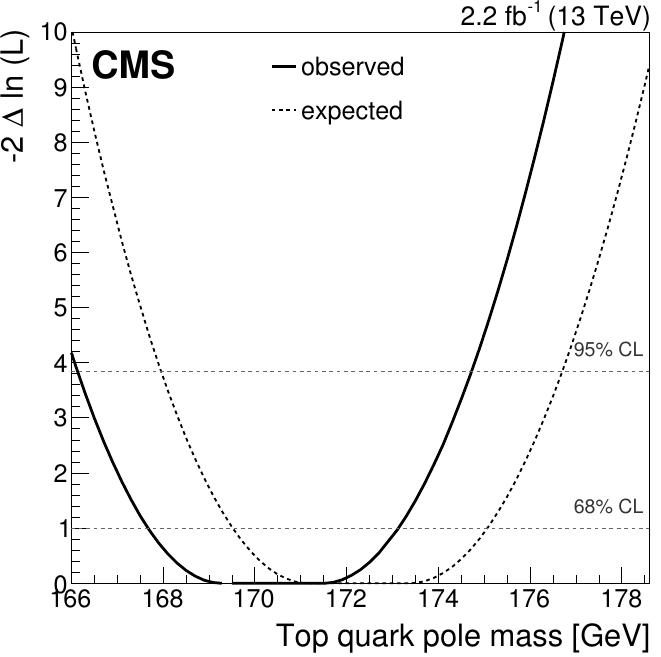
Figure 5 . Dependence of the likelihood on the top quark pole mass (solid curve). The expected dependence from the simulation, using the a priori set of nuisance parameters with their expected values at m t = 172 : 5 GeV, is shown for comparison as the dotted curve. The changes in the likelihood corresponding to the 68% and 95% con(cid:12)dence levels (CL) are shown by the dashed lines. NNLO+NNLL [45] computation with an uncertainty of 3.9%. We obtain an inclusive